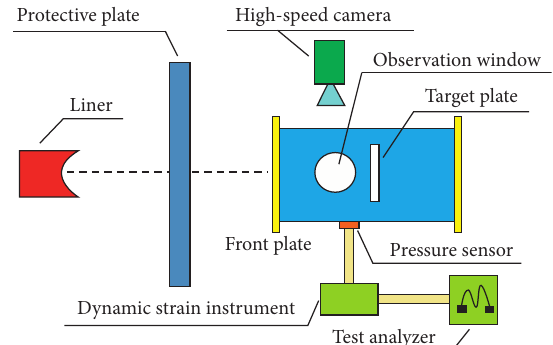
Figure 8: Schematic diagram of the energy acquisition system.